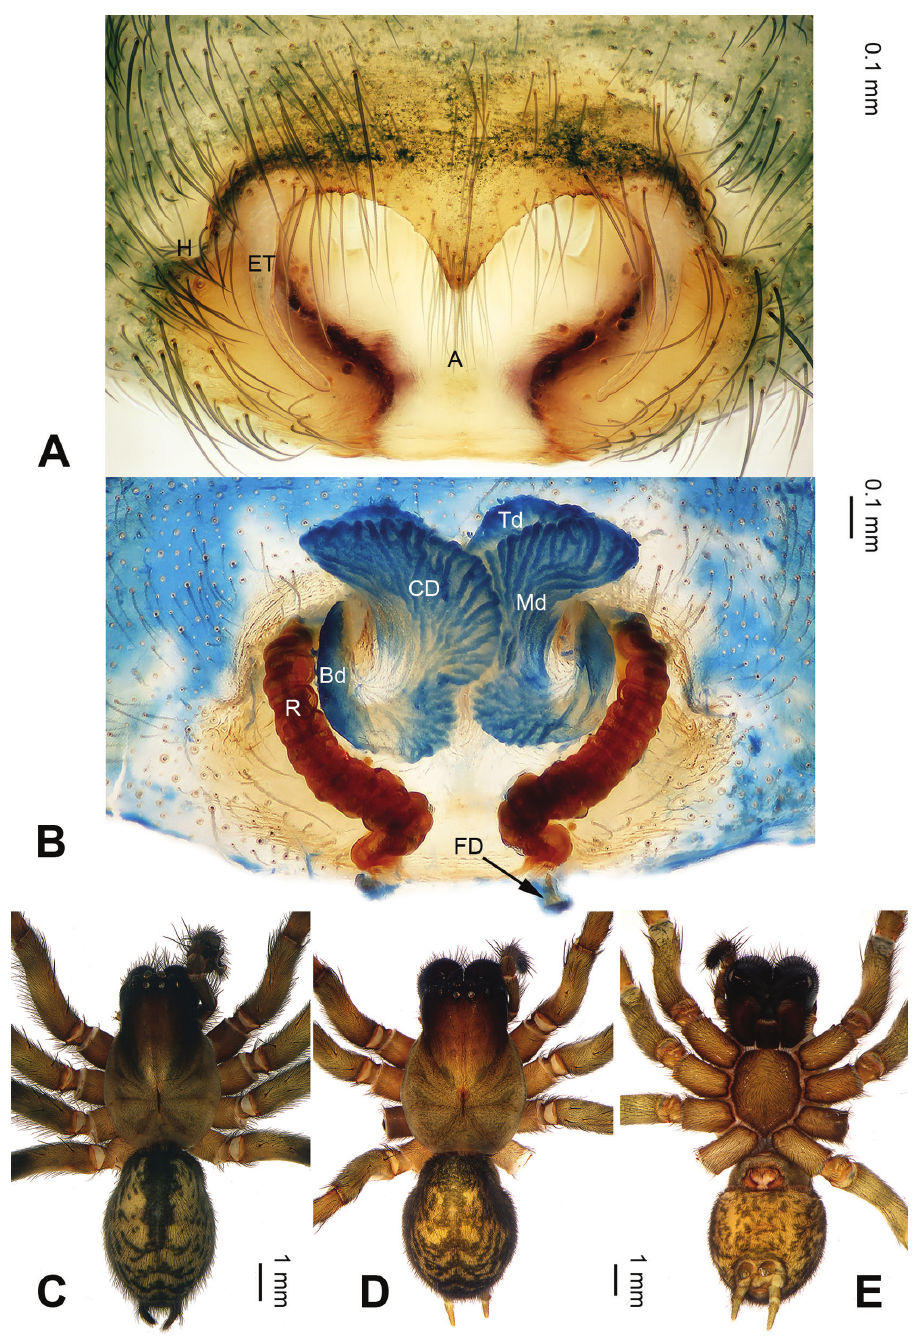
Figure 8. Pireneitega triglochinata , specimens from Mt. Emei. A Epigyne, ventral view B Vulva, dorsal view C Male habitus, dorsal view D Female habitus, dorsal view E Female habitus, ventral view. Scale bars: equal for D, E